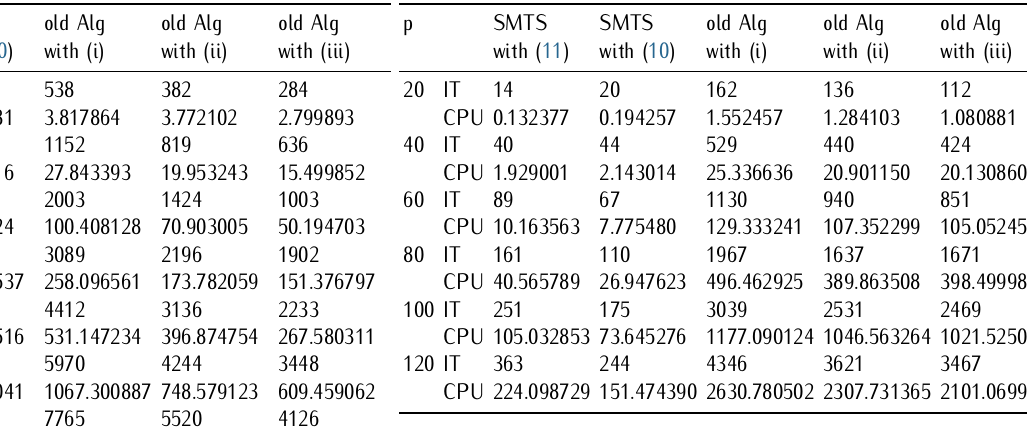
Table 1. Comparison of computational results for Example 1 Table 2. Comparison of computational results for Example